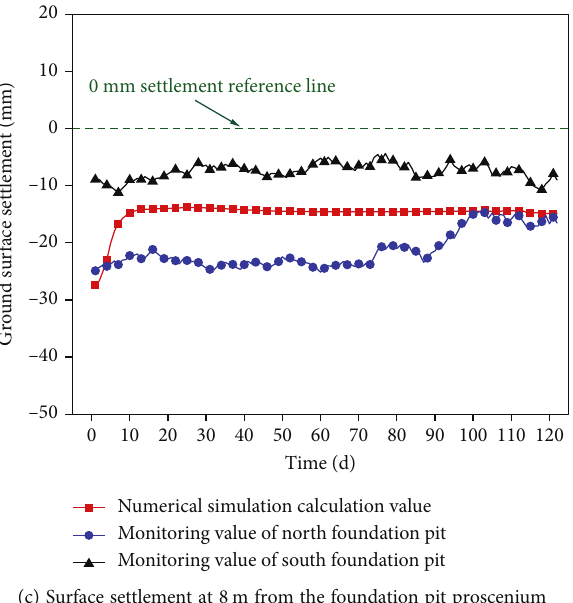
Figure 5: Comparison of surface settlement simulation results and monitoring